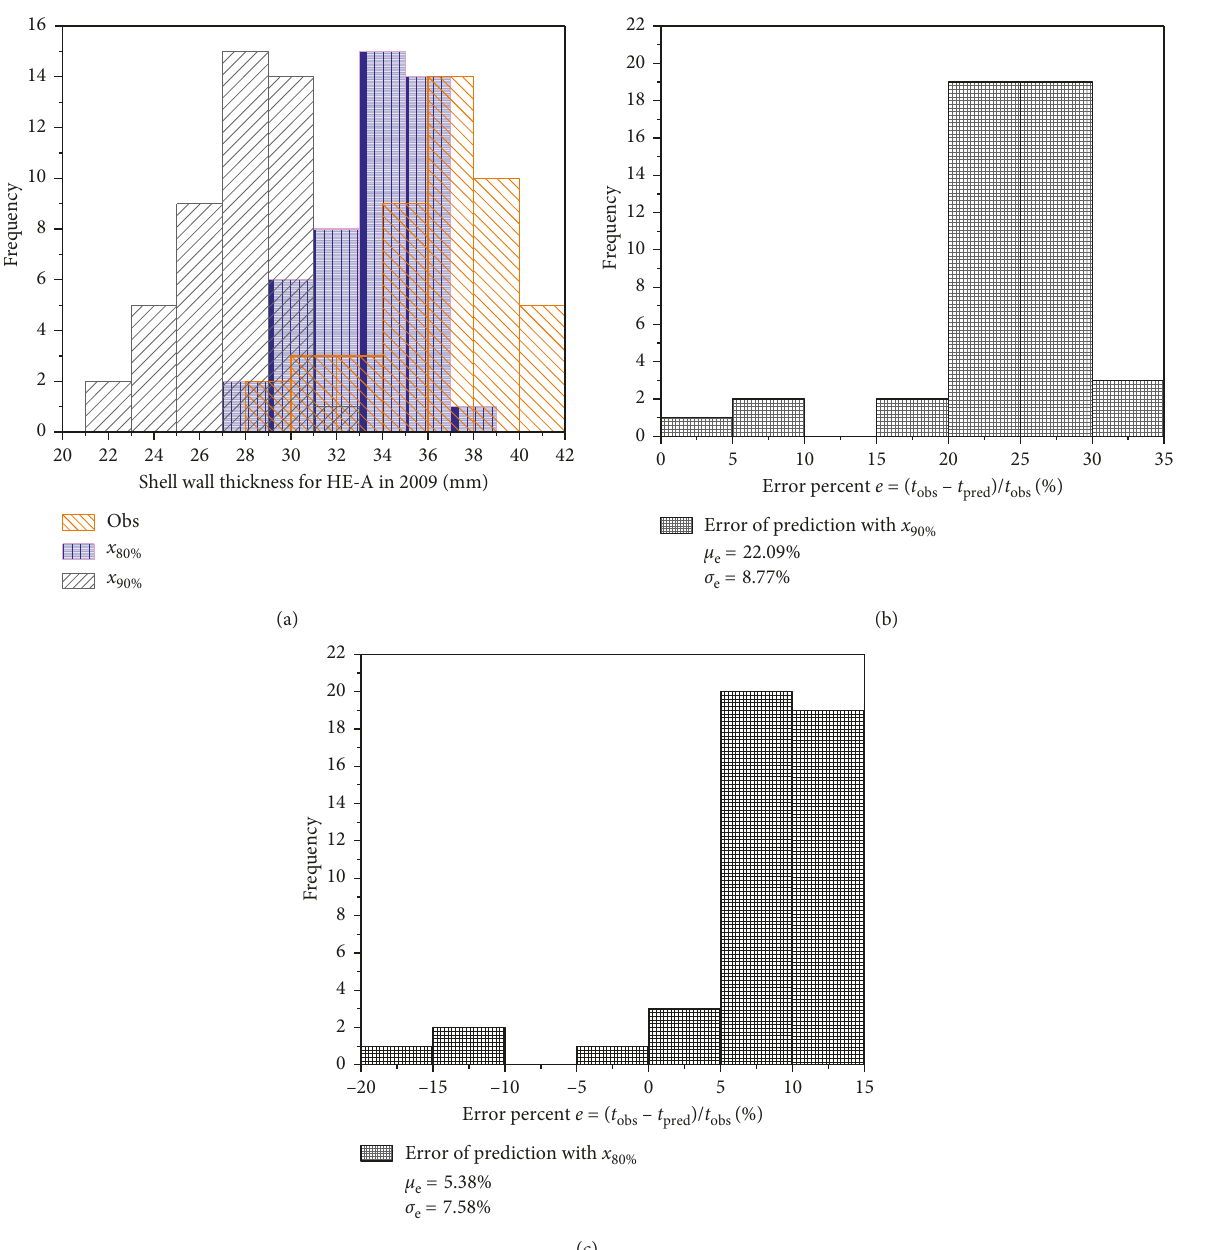
Figure 7: Histogram of the predicted wall thickness and the observations in HE-A (a) with the prediction error histogram using x 80% (cid:31)